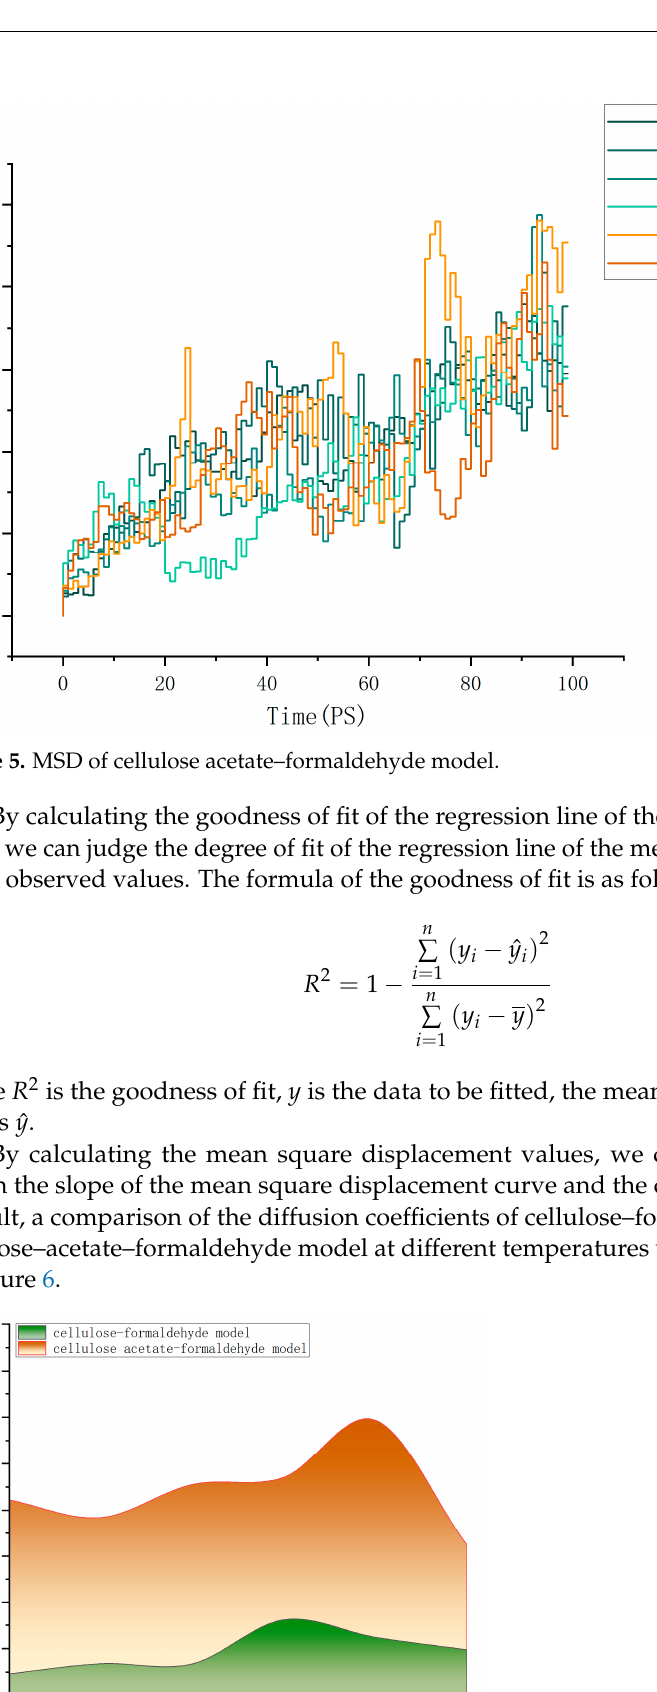
Figure 4. MSD of cellulose–formaldehyde model.